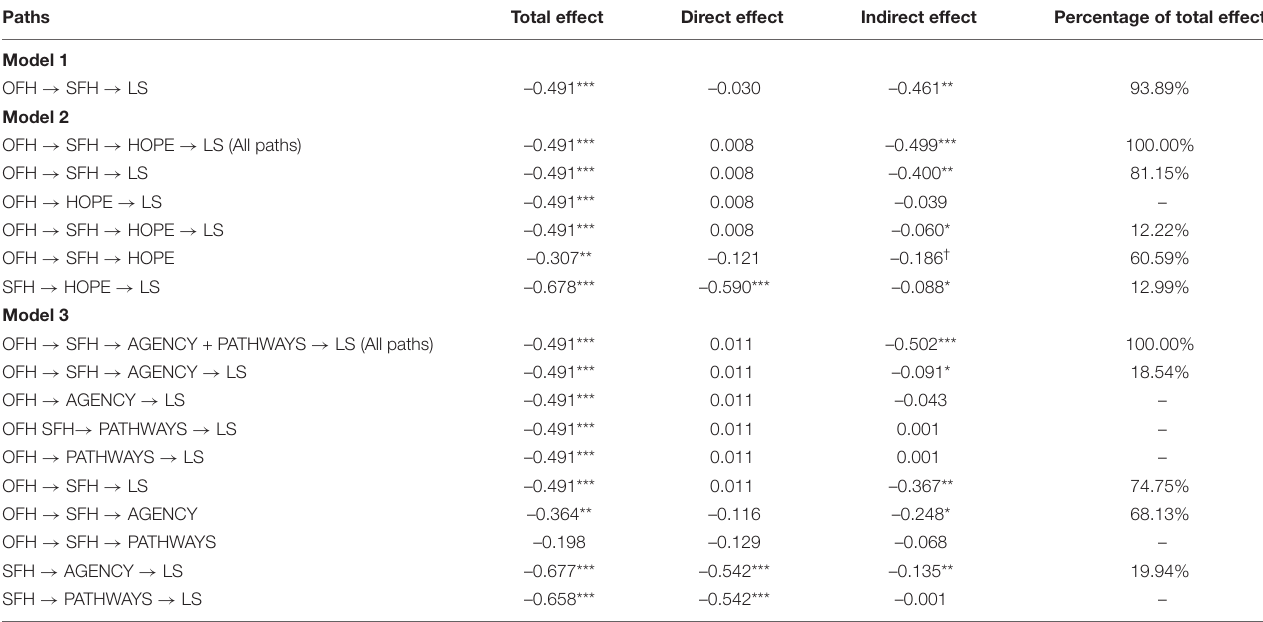
TABLE 3 | Total, direct, and indirect effects for Structural Equation Models 1, 2, and 3 ( N = 202). Paths